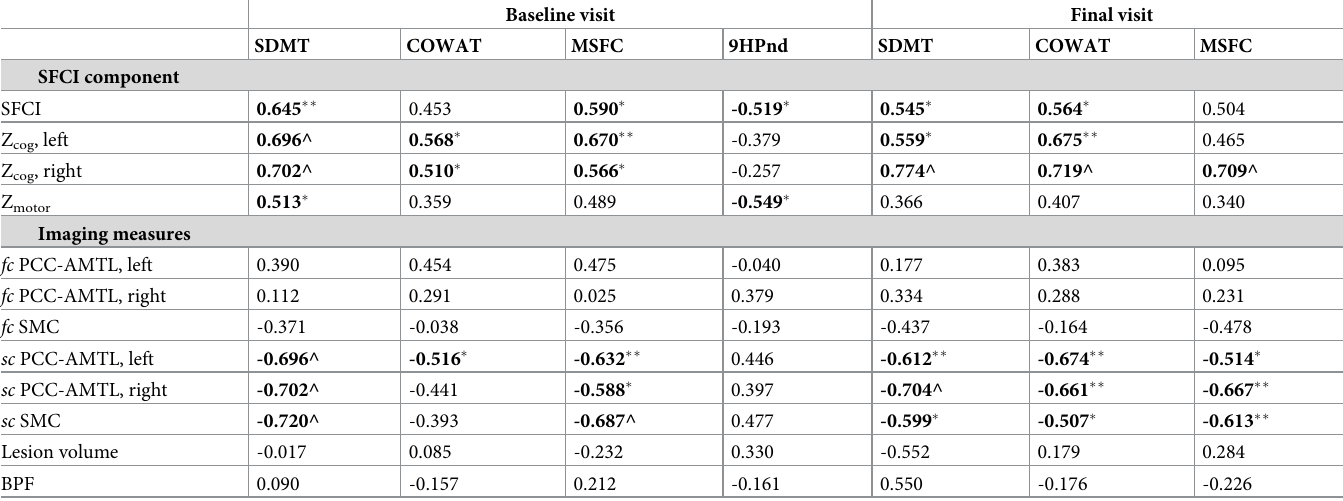
Table 5. Pearson correlation coefficients between baseline imaging measures and behavioral measures at baseline and the final visit in 20 participants with MS.